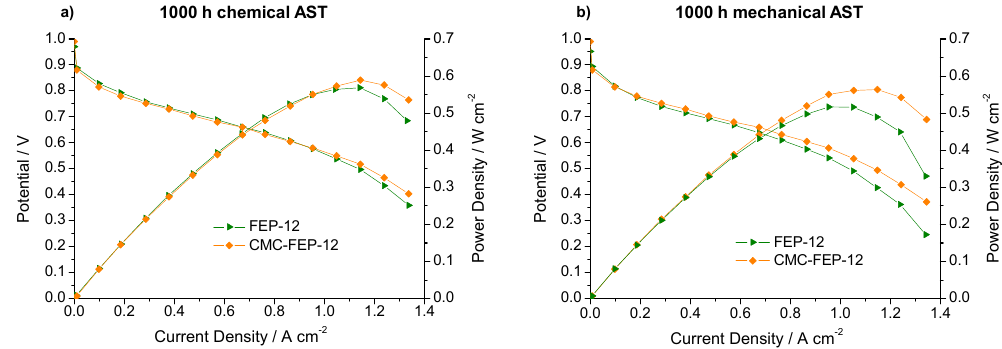
Figure 12. Polarization and power density curves, obtained upon 1000 h of: chemical ( a ); and mechanical ( b ) AST for FEP-12 and CMC-FEP-12 assembled cells.